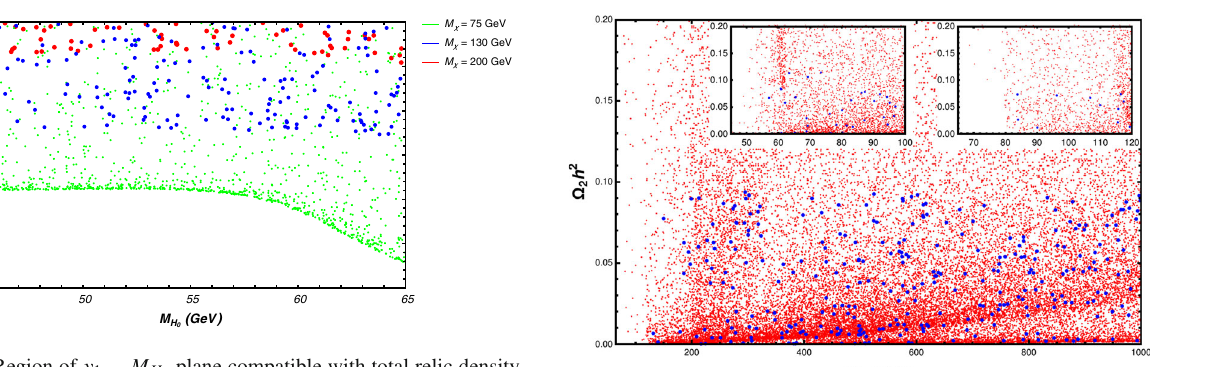
Fig. 5 Region of y 1 − M H plane compatible with total relic density 0 within the allowed range for selected values of M χ . Other variables are varied as per Table 1 Fig. 6 (cid:13) 2 vs M ψ for the parameter region considered in Table 1. 2 h Blue points are a subset satisfying the total relic density (cid:13) tot h 2 within the allowed range. Small mass region is enlarged for clarity : Top-left inset: for parameter region Case 2, Top-right inset: for parameter region Case 1 in Table